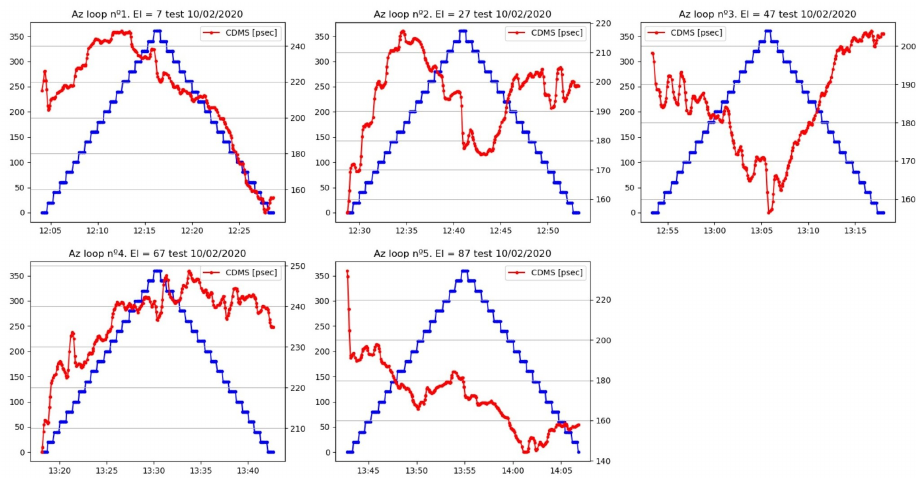
Figure 23. Zoom of the cable delay evolution during azimuth loops.